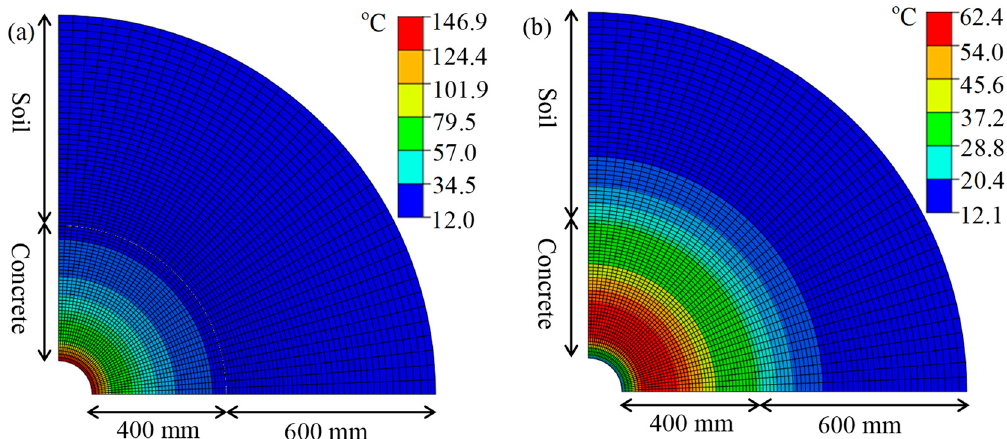
Figure 7. Temperature profile contour in the 1st loading cycle at: ( a ) 19:00; ( b ) 7:00 (end of the loading cycle).